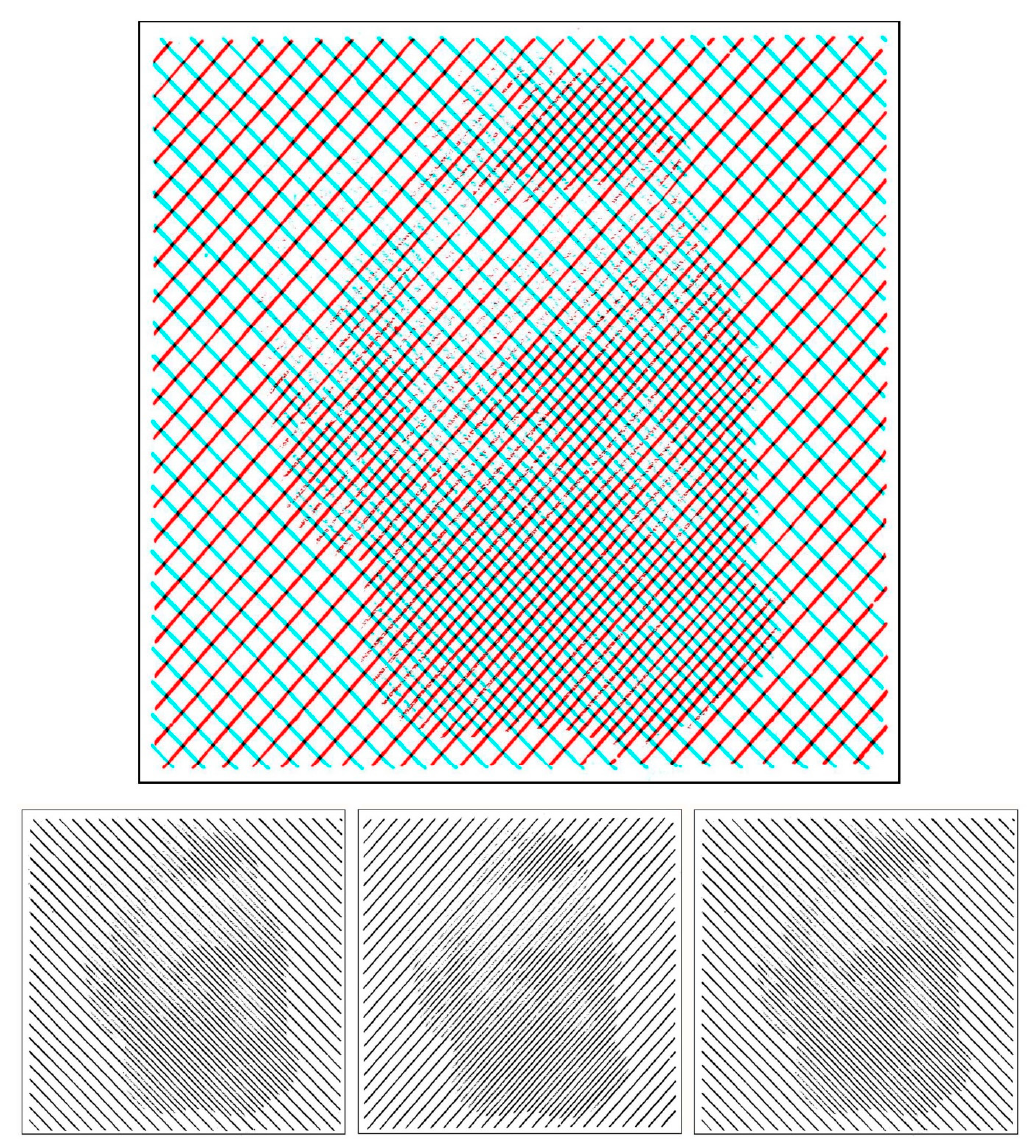
Figure 3. Panum’s rivalry areas by Nicholas Wade. A portrait of Panum is combined with the orthogonal gratings he illustrated in his book on vision with two eyes [22].